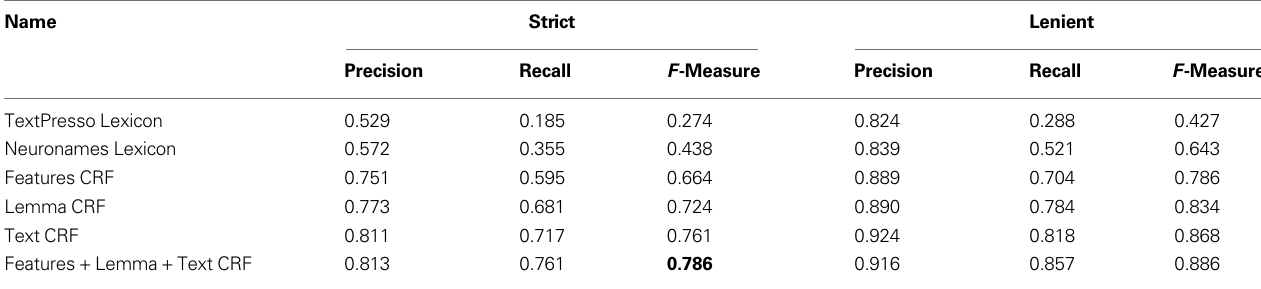
Table 2 | Results from evaluated techniques. Name